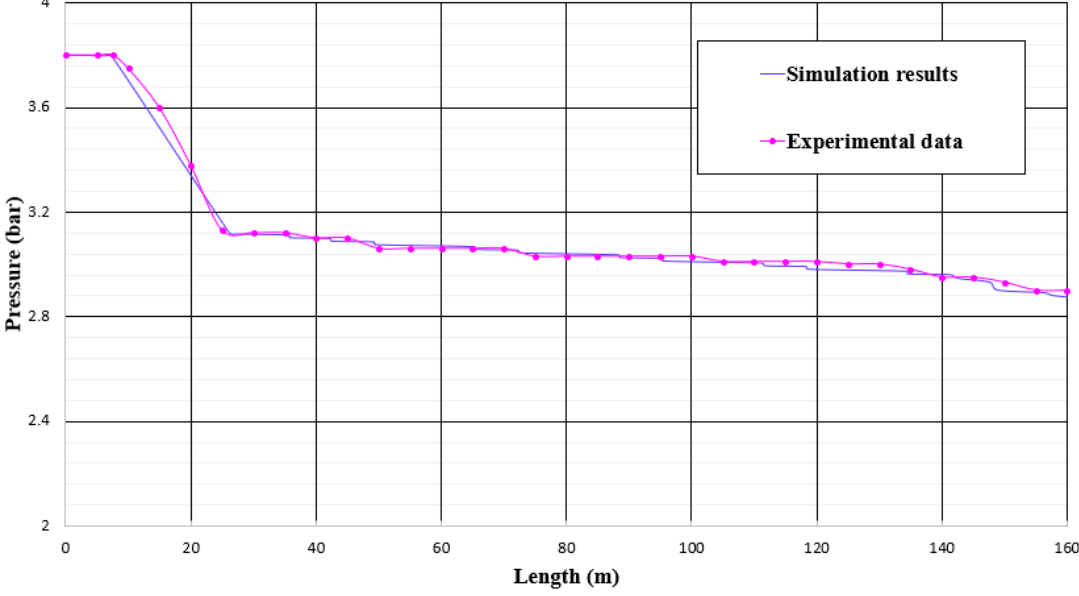
Figure 8. Land-based testbed for BTS ( left ) and piping and instrumentation diagram of real testbed ( right ).